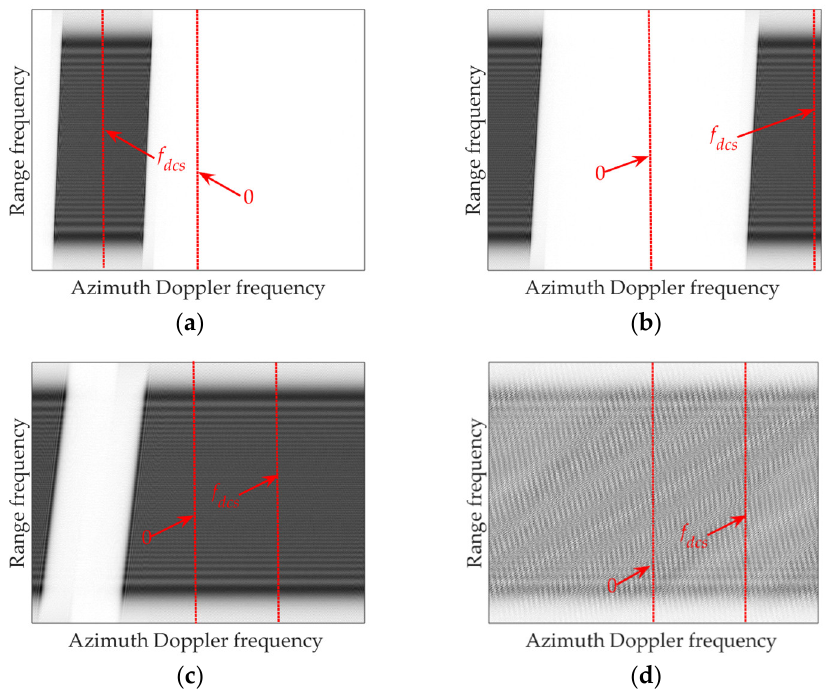
Figure 14. Theoretical 2D spectrum distributions of a moving target for CF-SAR: ( a ) spectrum entirely in a PRF band; ( b ) spectrum spanning neighboring PRF; ( c ) Doppler bandwidth exceeding PRF/2; and ( d ) Doppler bandwidth exceeding the PRF.